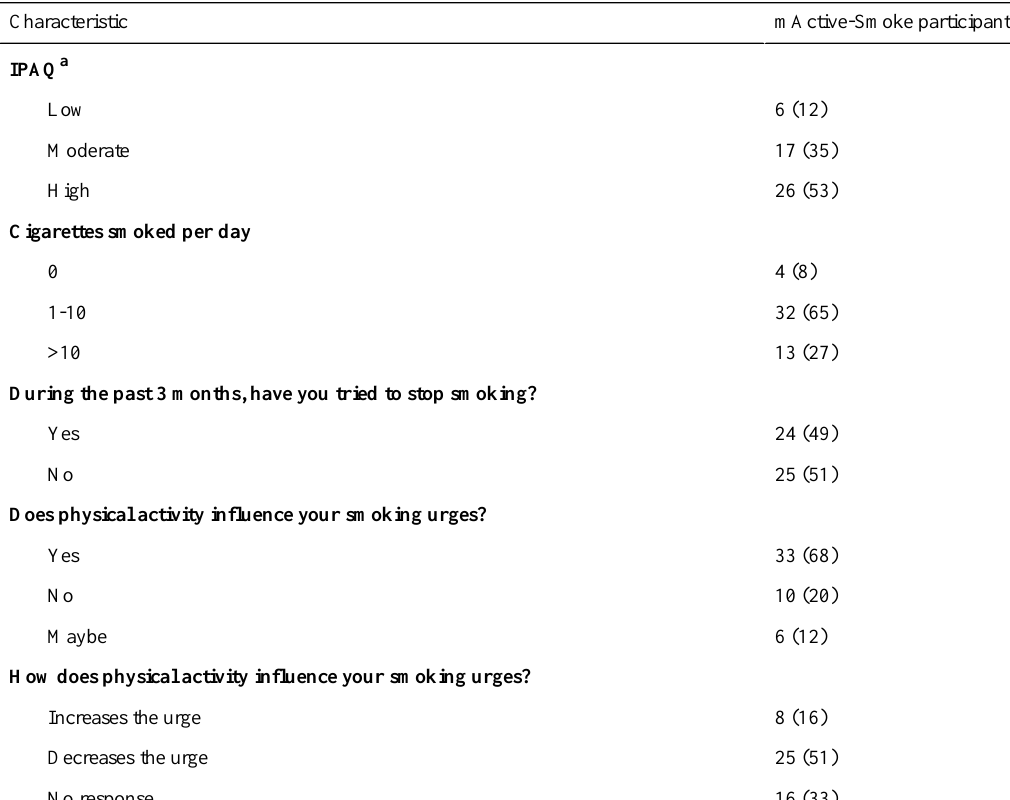
Table 3. Results from follow-up online exit